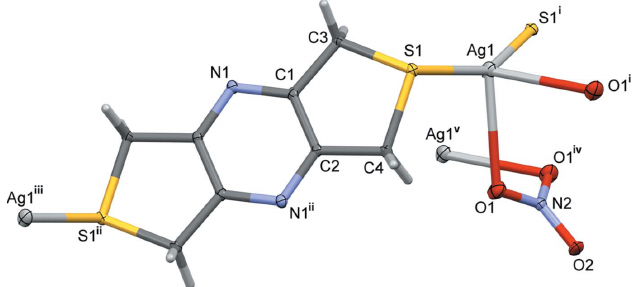
, (cid:4) z + 1 ; (ii) (cid:4) x , y (cid:4) 1 2 2 , (cid:4) z + 1 ]. Displacement ellipsoids are drawn at the 30% 2 2